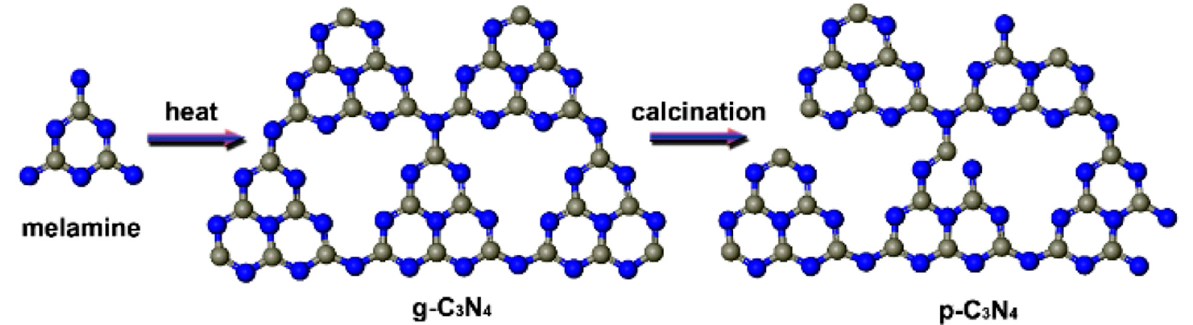
Figure 6. Schematic diagram for the formation of p-C 3 N 4